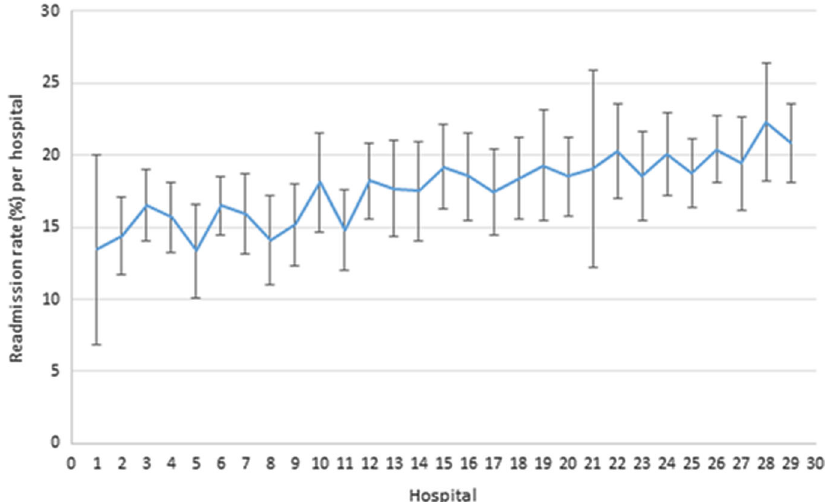
Fig. 2 COPD readmission rates to hospitals within 90 days. Readmission rates ( ± 95% CI) within 90 days of all COPD patients admitted (18,848) to included English hospitals between 2006 and 2010, and adjusted for clustering, age and sex of